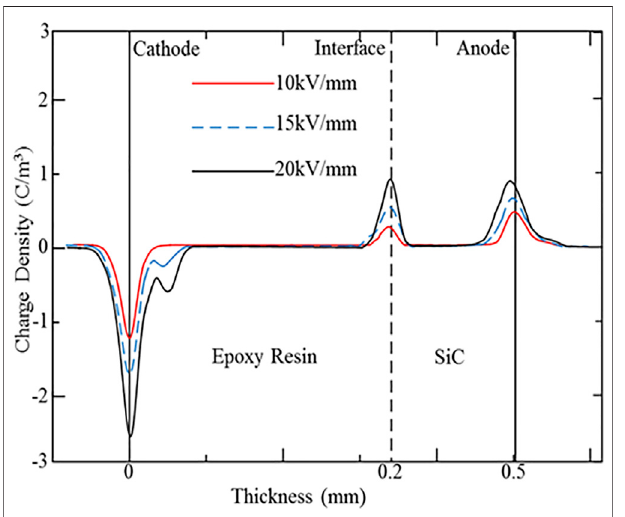
FIGURE 3 | Space charge pro fi les for the SiC – epoxy resin double- layered sample under different DC electrical stresses.